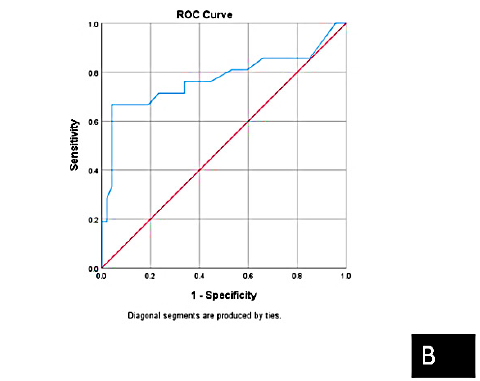
Figure 4. Receiver operator characteristics (ROC) curve presents the diagnostic accuracy of the ABHD4 RNA panel discriminating between UA and STEMI: ( A ) ABHD4 mRNA and miRNA-197-5p a ( B ) FENDRR lncRNA.